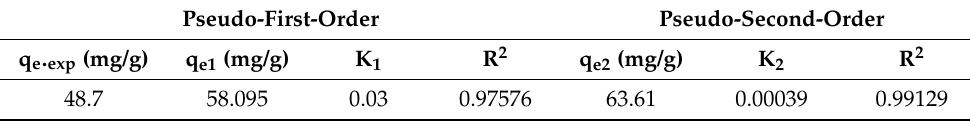
Table 4. Comparison of pseudo-first-order and pseudo-second-order